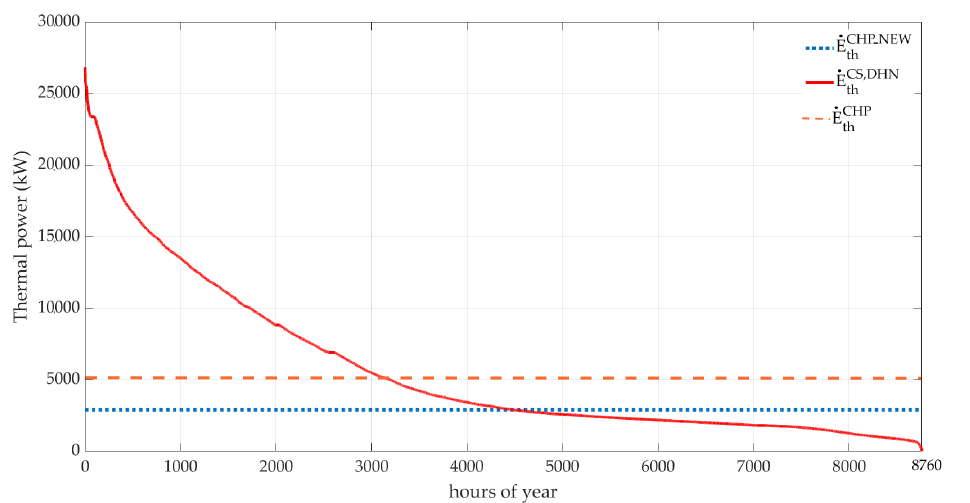
Figure 4. Thermal load duration curve (year 2020) due to the DHN vs. the old and new CHP nominal thermal